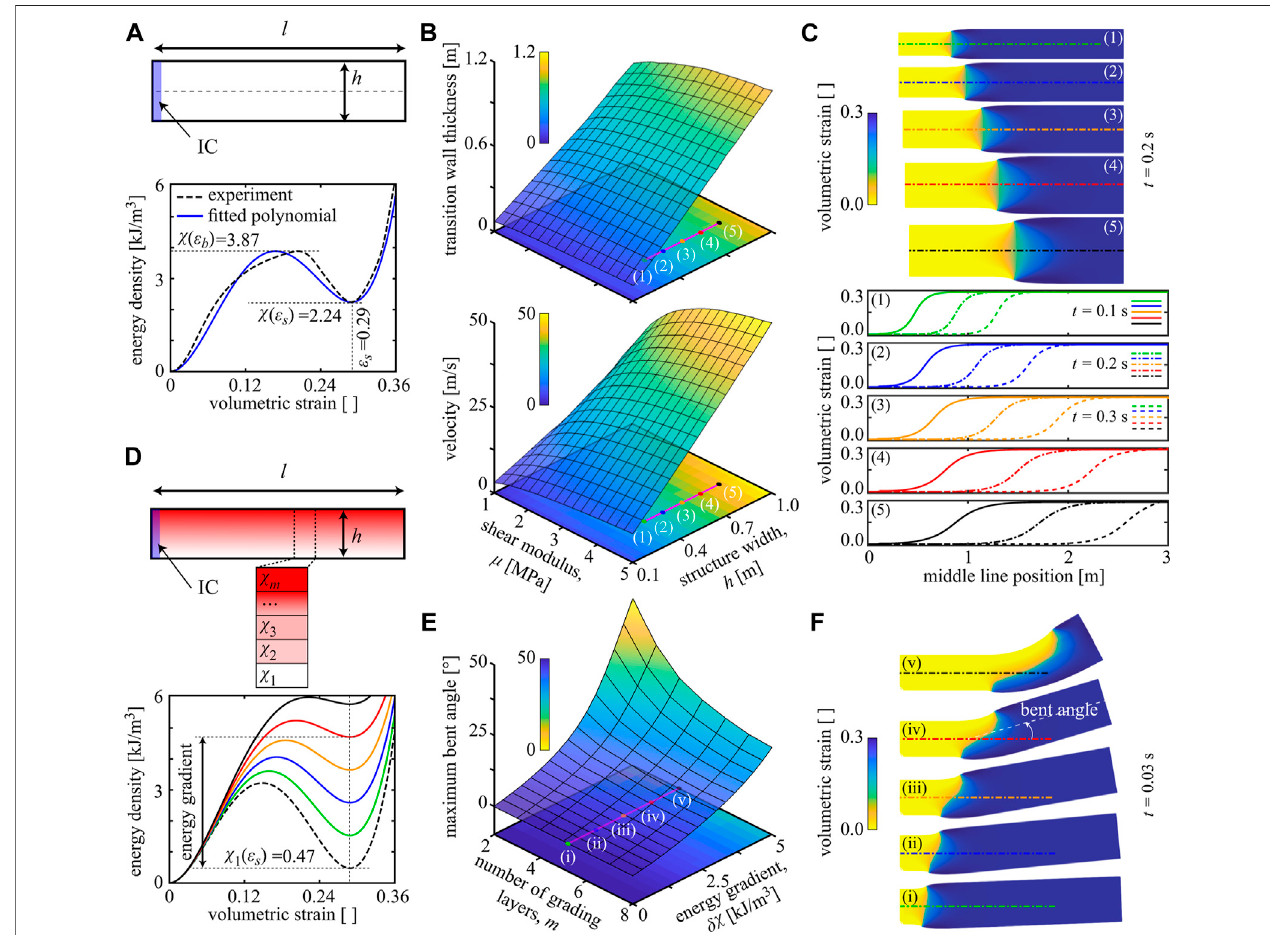
FIGURE 3 | Bistability and structural dimensions control the recon fi guration. (A) A structure with l (cid:1) 3 m and varying h is initially in its open state, except for the highlighted area with the initial condition (IC) of being in the closed state. This initiation causes a transition front propagating from left to right. Double-well energy density extracted from Jin et al. (2020) and its quartic polynomial fi t. (B) The velocity and thickness of the transition wave for varying structural width h and shear modulus μ values. (C) Snapshotsofthesimulatedtransitioningstructureandthewavepro fi leattheircenterline,correspondingtothemarkedpointsin Figure3B ,atthethree instancesof t (cid:1) 0.1 s(solidline), t (cid:1) 0.2 s(dash-dottedline),and t (cid:1) 0.3 s(dash-dottedline). (D) Arectangularstructurewith l (cid:1) 8 h ismadefromunitcellswhosegeometry (dimensions)changesverticallyacrossthestructure;unitcellsatthebottomhavethedashedenergydensitycurve,whilecellsatthetophavethesolidblackenergycurve (at fi xed μ (cid:1) 1MPa). (E) Maximum bent angle of the graded structure in (D) as a function of the energy differential δχ (cid:1) χ m ( ε s ) − χ 1 ( ε s ) and the number of grading layers m . (F) The graded structure ’ s motion corresponding to the marked values of Figure 3E at t (cid:1) 0.03 s (for β / Δ t (cid:1) 0 . 2MPa).